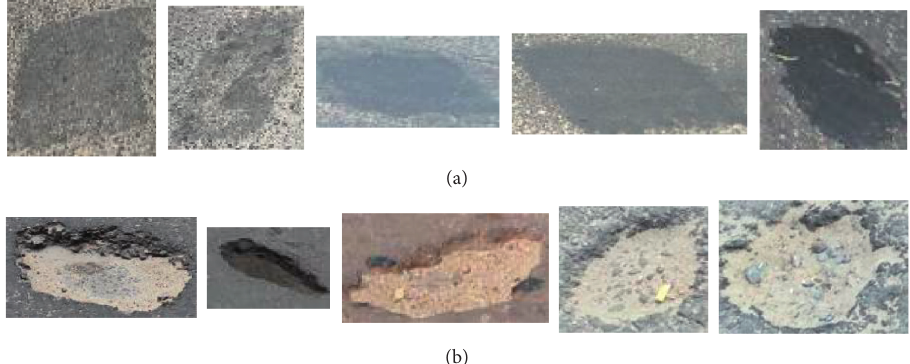
Figure 5: Demonstration of the collected image samples: (a) Class label − 1 (patched pothole) and (b) Class label +1 (unpatched